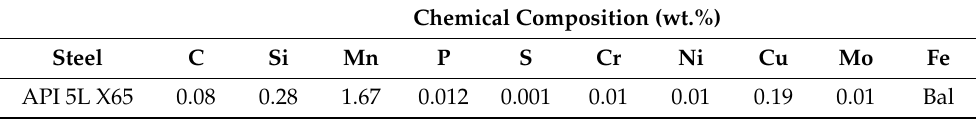
Table 5. Chemical composition of the pipe line steel API 5LX65